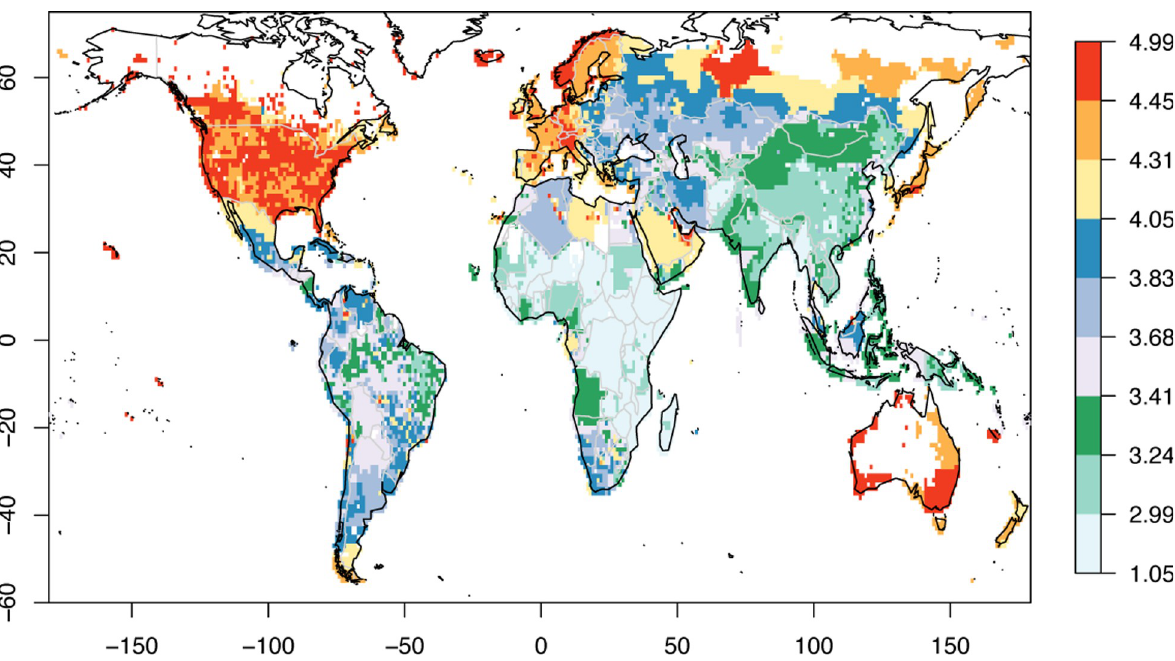
Fig 1. Map of log Gross Cell Product per capita. GCP per capita in log 10 (k USD/person). Note that the colour palette has been divided into three sets of three colours each, which represent the three terciles, whose thresholds are 3.41 and 4.05, respectively (cf. Fig 2). Source G-Econ [21].